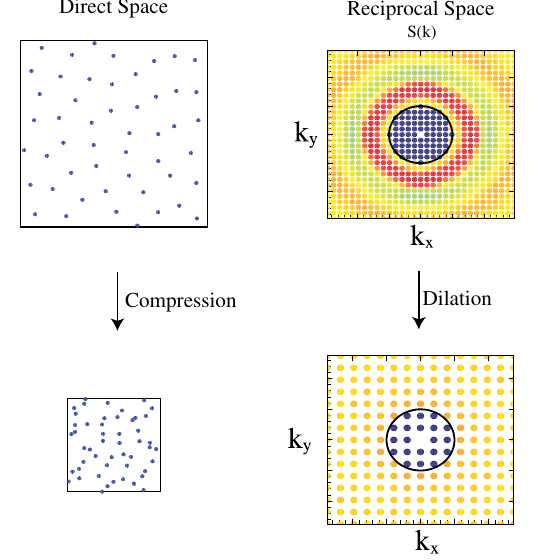
FIG. 1. Schematic illustrating the inverse relationship between the direct-space number density ρ and relative fraction of con- strained degrees of freedom χ for a fixed reciprocal-space exclusion-sphere radius K (where dark blue k points signify zero intensity with green, yellow, and red points indicating increasingly larger intensities) for a stealthy ground state. A compression of a disordered ground-state configuration with a fixed number of particles N in direct space leads to a dilation of the lattice spacing in reciprocal space. This means that during the compression process, the k points for which j ~ n ð k Þj is zero associated with the initial uncompressed system move out of the exclusion zone; i.e., the value of M ð K Þ [cf. Eq. (2)] decreases. Since there are fewer constrained degrees of freedom (dimen- sionality of the ground-state configuration manifold increases), the disordered direct-space configuration becomes less spatially correlated. For a fixed N in the limit ρ → ∞ (i.e., system volume → 0 ), every k point (except the origin) is expelled from the v F exclusion zone, and the system tends to an ideal-gas configura- tion [30], even if it is not an ideal gas thermodynamically, as shown in Sec. IV B.